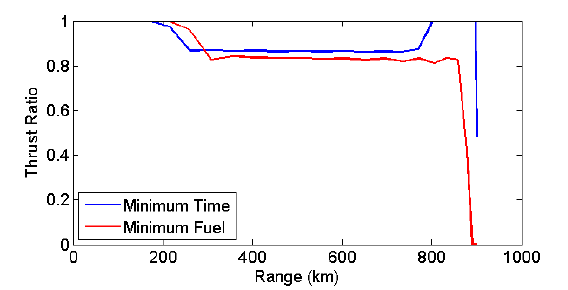
Fig. 5: Thrust ratio profile for minimum time and minimum fuel burn.